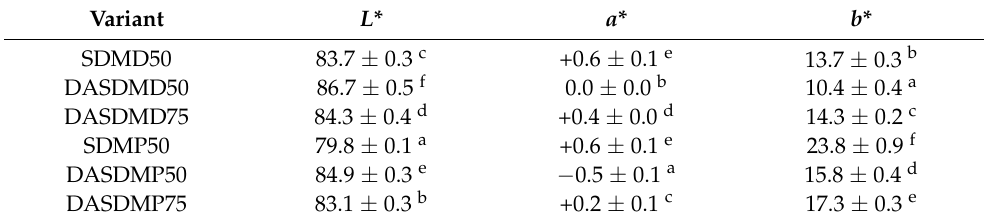
Table 5. Color parameters L * a * b * of buckwheat honey powders obtained by high temperature tradi- tional spray drying (SD) and low temperature spray drying with the application of dehumidified air (DASD) with maltodextrin (MD) and milk powder (MP) as a carrier, containing 50–75% honey solids. Variant L * a * b * SDMD50 83.7 ± 0.3 c +0.6 ± 0.1 e 13.7 ± 0.3 b DASDMD50 86.7 ± 0.5 f 0.0 ± 0.0 b 10.4 ± 0.4 a DASDMD75 84.3 ± 0.4 d +0.4 ± 0.0 d 14.3 ± 0.2 c SDMP50 79.8 ± 0.1 a +0.6 ± 0.1 e 23.8 ± 0.9 f DASDMP50 84.9 ± 0.3 e − 0.5 ± 0.1 a 15.8 ± 0.4 d DASDMP75 83.1 ± 0.3 b +0.2 ± 0.1 c 17.3 ± 0.3